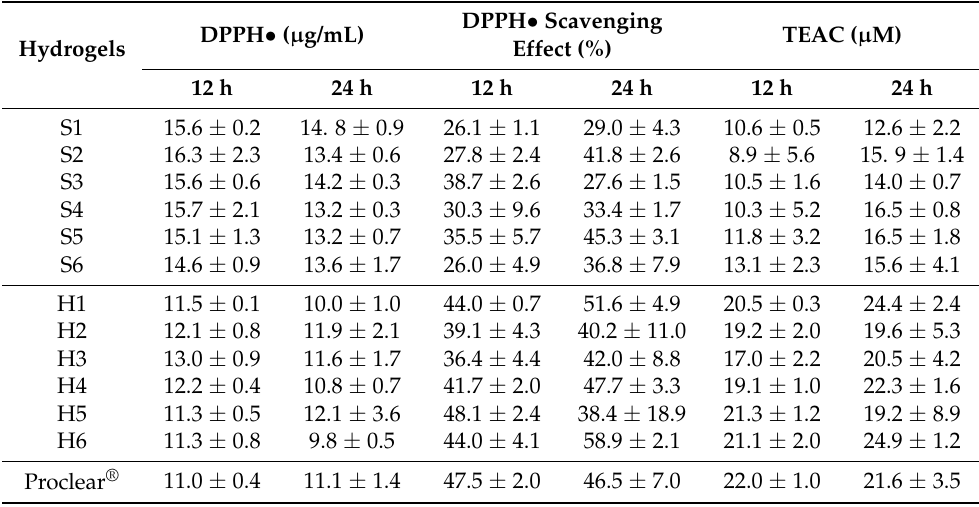
Table 4. DPPH • levels ( µ g/mL), DPPH scavenging effect (%) and Trolox equivalent antioxidant capacity (TEAC). All data are mean ± SDs ( n = 3).